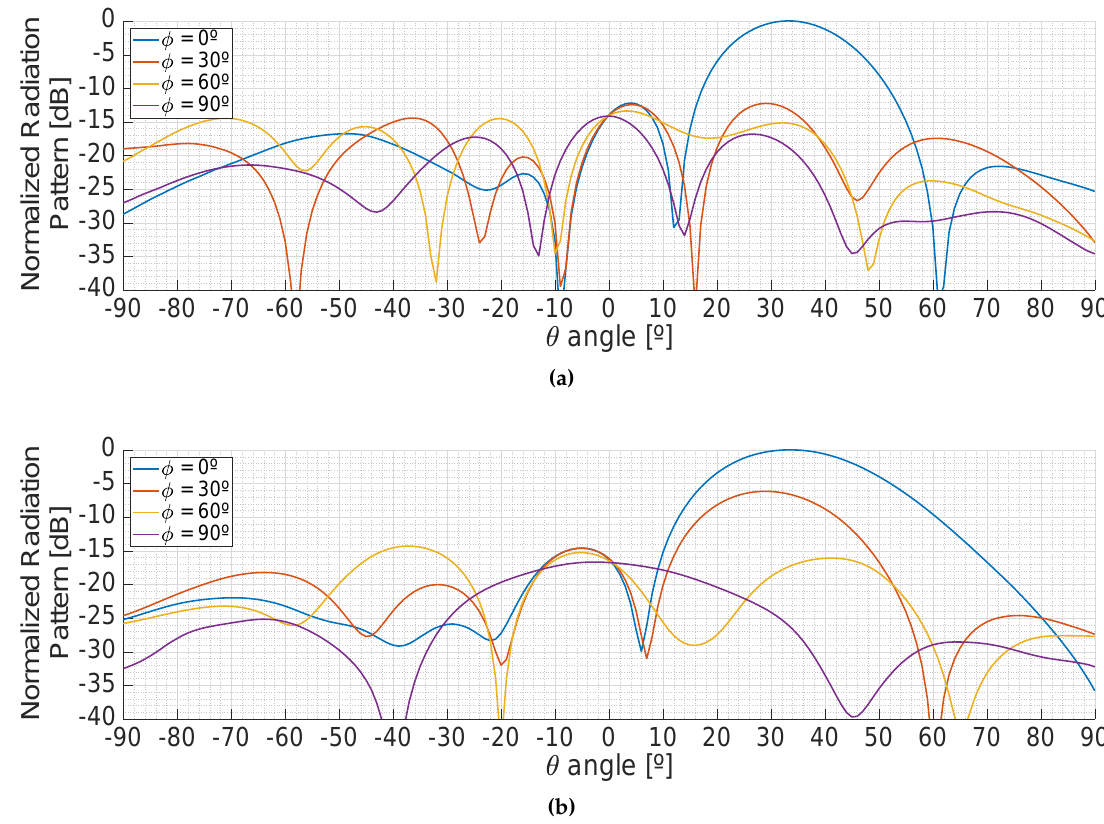
Figure 25. Side lobes for different azimuthal cuts of the antenna pattern when pointing to an off-boresight angle of 35 ◦ at the L1/E1 ( a ) and L5/E5 ( b ) frequency bands,